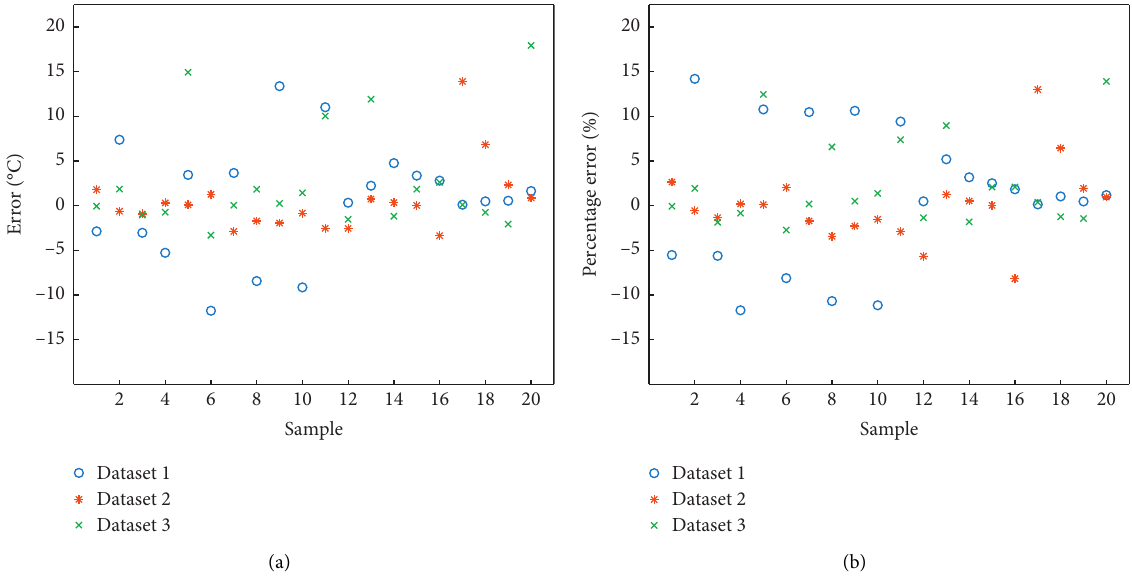
Figure 8: (a) The temperature errors of 20 samples. (b) The percentage errors of 20 samples.